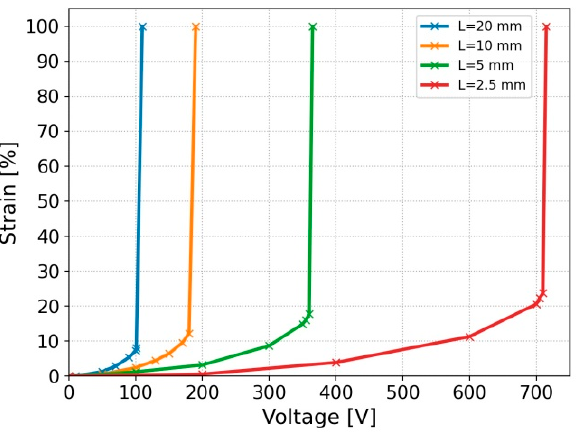
Figure 5. Voltage-strain characteristics for four length values of the actuator.